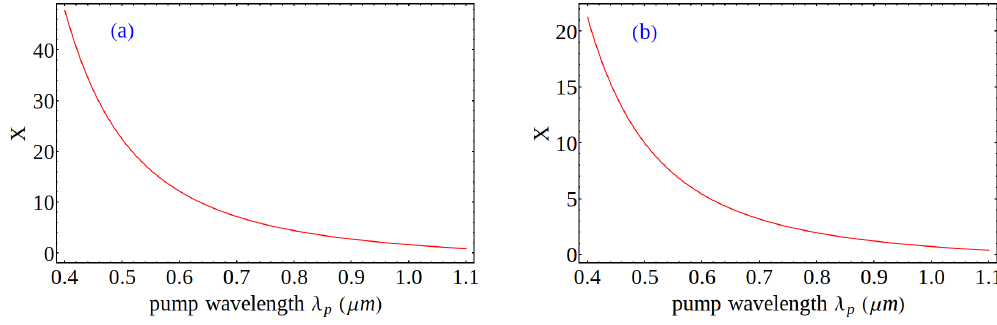
Figure 3. X from Equation (16) is plotted as a function of the pump wavelength for scenarios depicted in Figure 1 and Equation (2) for a graded-index multimode optical fiber: ( a ) for scenario (a) with Ω = ω / 2 ; and ( b ) for scenario (b) with Ω = ω / 3 . The degenerate p p intermodal FWM scenario is possible only if X is equal to an